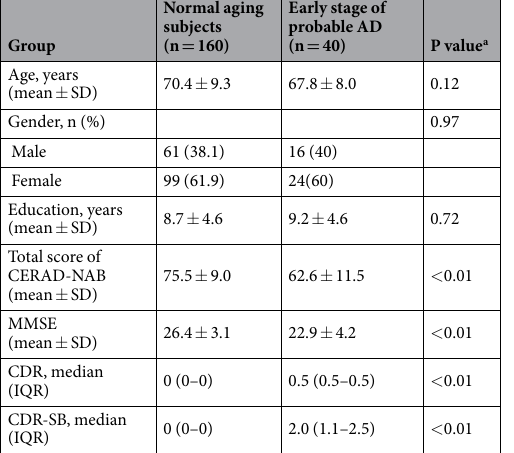
Table 1. Demographic characteristics of the normally aging and the early stage of probable AD groups. Abbreviations: SD, standard deviation; AD, Alzheimer’s disease; MMSE, Mini Mental State Examination; CERAD-NAB, Consortium to Establish a Registry for Alzheimer’s Disease Neuropsychological Assessment Battery; CDR, Clinical Dementia Rating; CDR-SB, Clinical Dementia Rating-sum of box; IQR, interquartile ranges. a Tested by the chi-square tests and the Mann-Whitney U